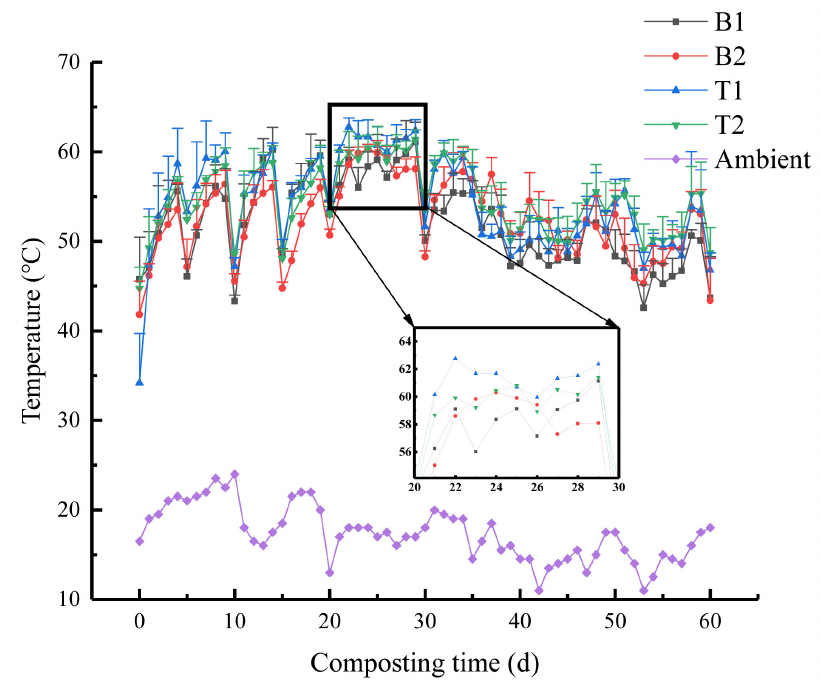
Figure 2. Evolution of temperature during composting. B1, V mushroom residue: V sheep manure = 5:1, with CMA inoculation; B2, V mushroom residue: V sheep manure = 5:1, without inoculation; T1, V mushroom residue: V sheep manure = 9:1, with CMA inoculation; T2, V mushroom residue: V sheep manure = 9:1, without inoculation.